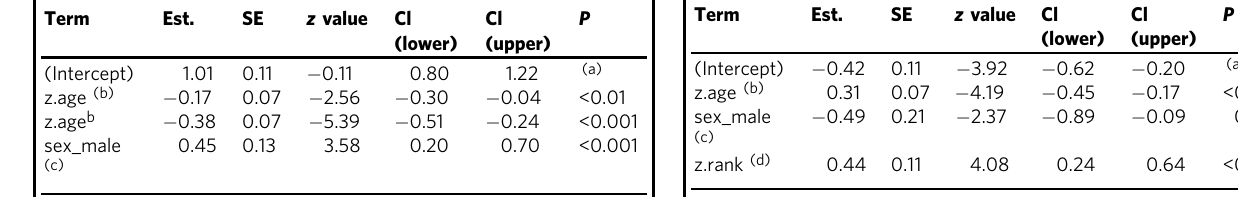
Estimates (Est.) with standard error (SE), test statistic z , lower and upper con fi dence limit (Cl), and P values are given ( N = 84 subjects).